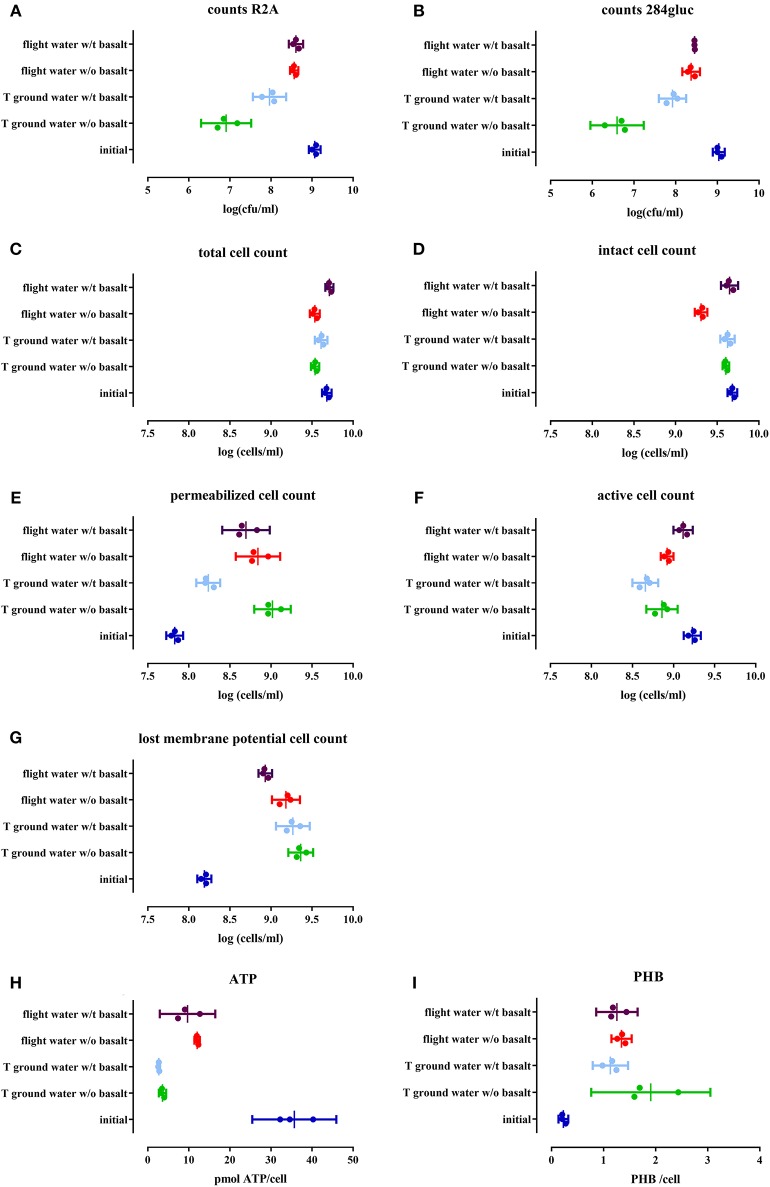
Cell physiology, cultivability, ATP and PHB levels of an initial stationary phase culture of CH34 cells stored in mineral water with (indicated with w/t) and without (w/o) basalt, analyzed after the three month flight experiment and after the control temperature ground experiment. All replicates are represented by a dot; the mean is indicated as a line as well as the 95% confidence interval between the brackets. For the statistical analysis, one way ANOVA was used with Tukey post testing (alpha = 0.05), p-values as well as significance are reported in Table 4 and in Supplementary Table S2. Samples were plated on R2A (A) and 284 MM (B) to determine cultivability of CH34. The total cells number (SG) (C) as well as the number of intact cells (SGPI) (D), permeabilizated (SGPI) (E), active (cFDA) (F), and cells which have lost their membrane potential [DIBAC4(3)] (G) were measured. ATP (H) and PHB (I) content of the cells was also measured.